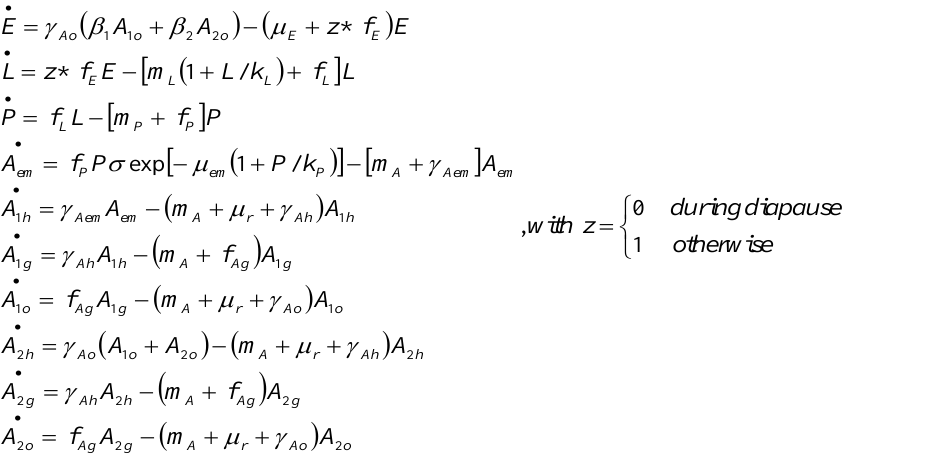
Figure 2. Model diagram of Aedes albopictus population dynamics in temperate climate. Aquatic stages are drawn in blue, adult females in yellow. The green compartments indicate the adult females which move to seek for a host or an oviposition site. Adapted from Cailly et al. [17]. Reprinted from Ecological Modelling, 227/24 February 2012, Cailly, P.; Tran, A.; Balenghien, T.; L’Ambert, G.; Toty, C.; Ezanno, P., A climate-driven